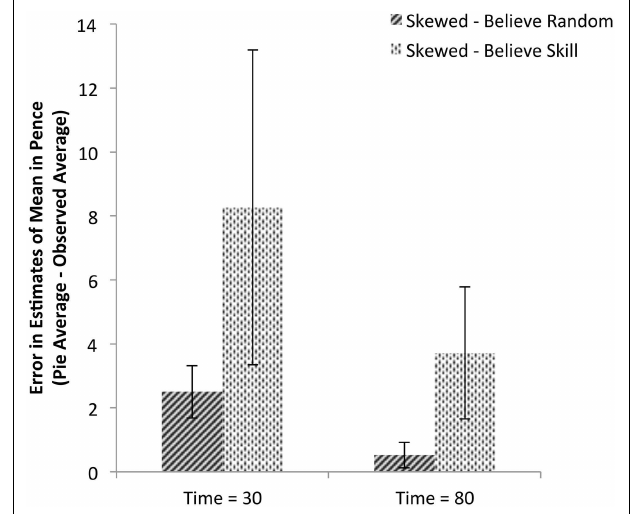
FIGURE 5 | Mean error in payout estimation based on structural beliefs. Mean payout estimate errors are shown for those participants given skewed payout tables, split based on whether the participant responded with the belief that the machine play was random or based on skill (8 of 26 participants); data from the control group of participants shown accurate payout tables is not included because only 1 of 27 participants expressed belief that machine play was based on skill.Values greater than zero indicate overestimation and values close to zero indicate accurate estimation. Errors for both the left and right machines were averaged resulting in one error measure per participant per judgment during machine